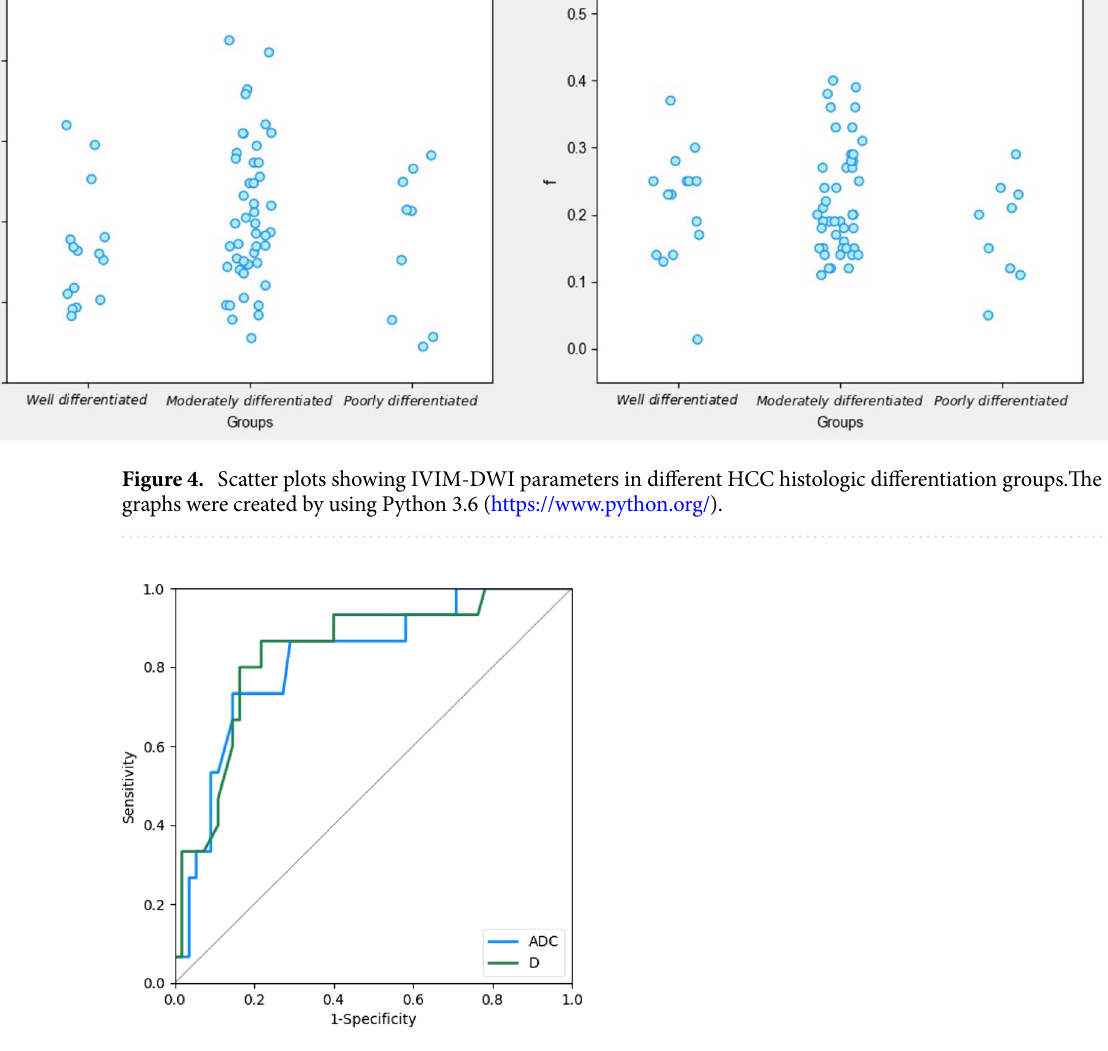
Figure 5. The efficacy of IVIM-DWI parameters for the diagnosis of well differentiated HCC. The ROC curves were created by using Python 3.6 (https:// www. python.